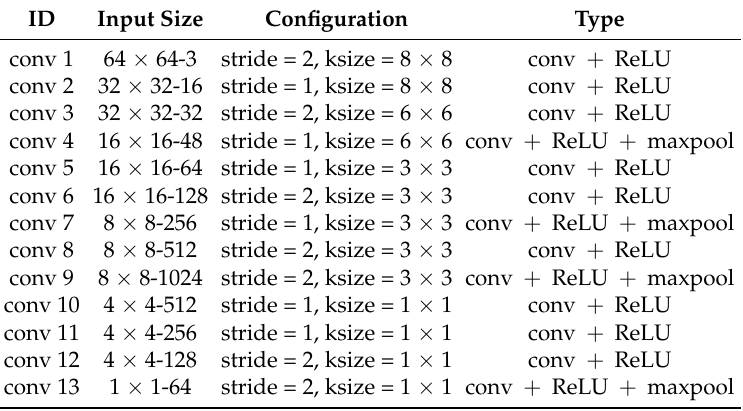
Figure 3. Architecture of the convolution neural network (CNN) module, with 13 conventional layers, three fully-connected layers and a softmax layer. Table 1. Configuration of each convolutional layer in Figure